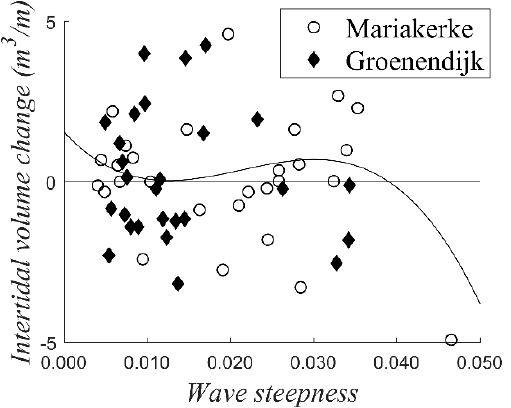
Figure 9. Daily intertidal beach volume change compared to daily averaged wave steepness.